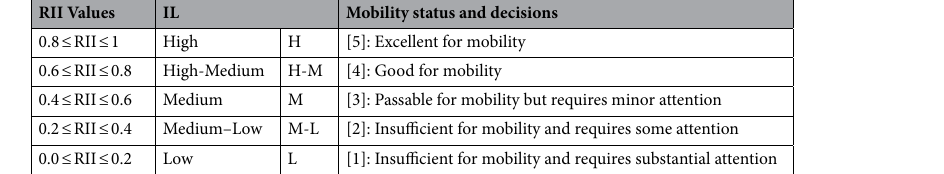
Table 3. RII values-IL levels-mobility status and